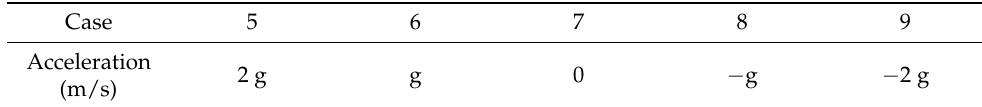
Table 2. Acceleration used in entry with constant acceleration